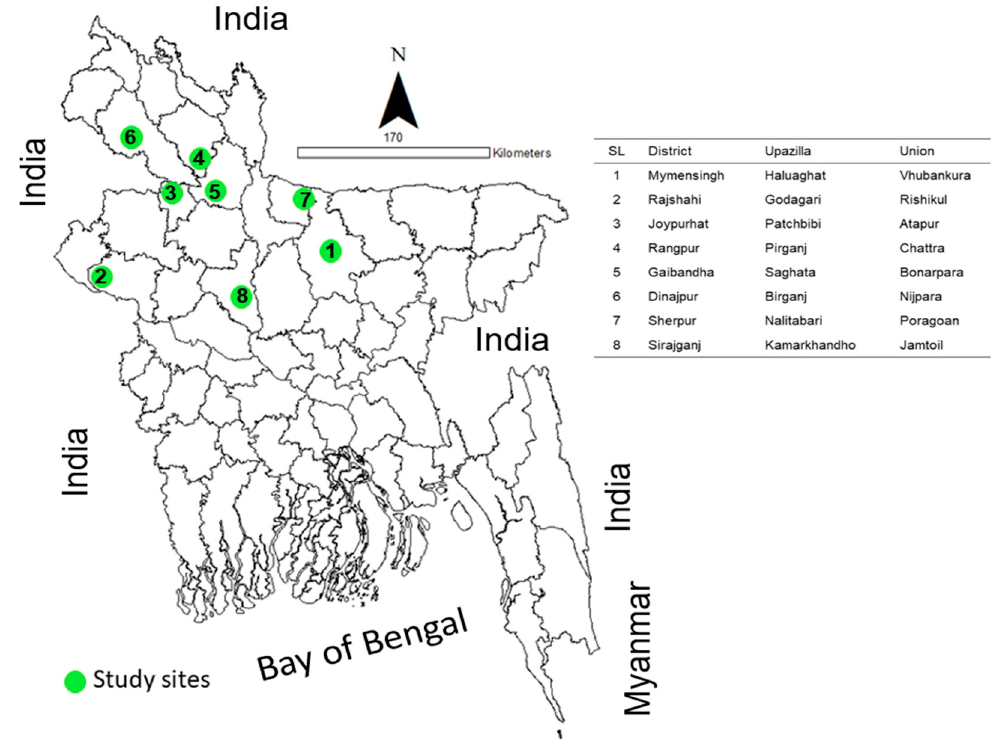
Figure 1. A geographical map of Bangladesh showing the locations of the study areas.